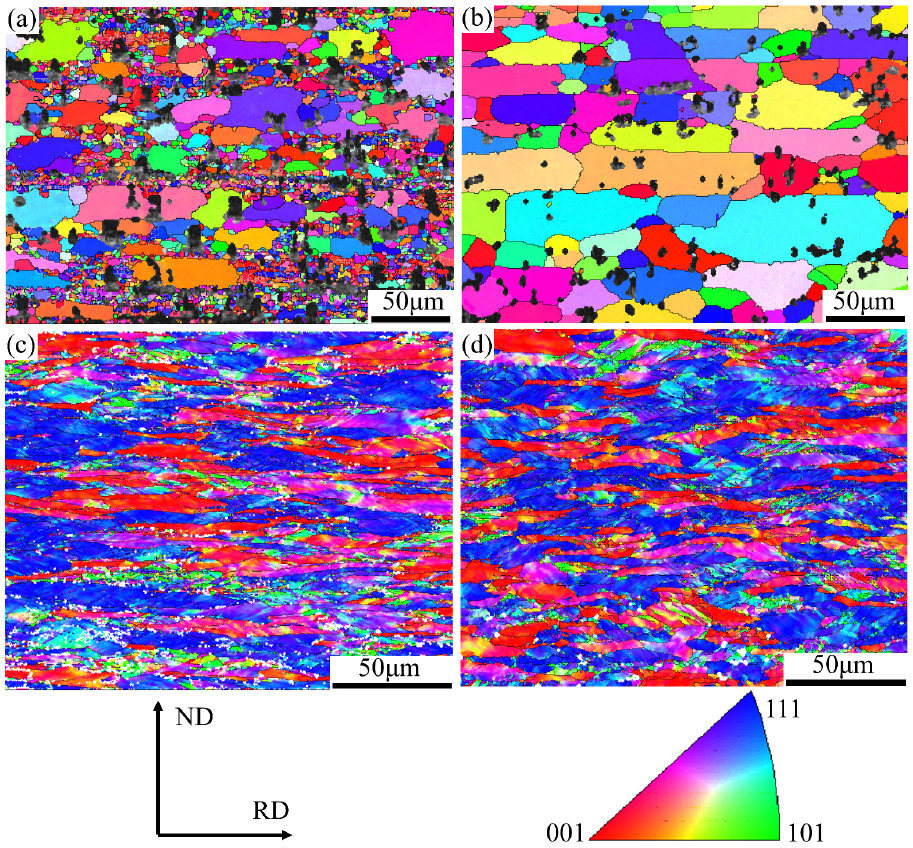
Figure 6. Inverse pole figures (IPFs) of samples: ( a ) initial Al layer, ( b ) aged Al layer, ( c ) initial steel layer, and ( d ) aged steel layer.